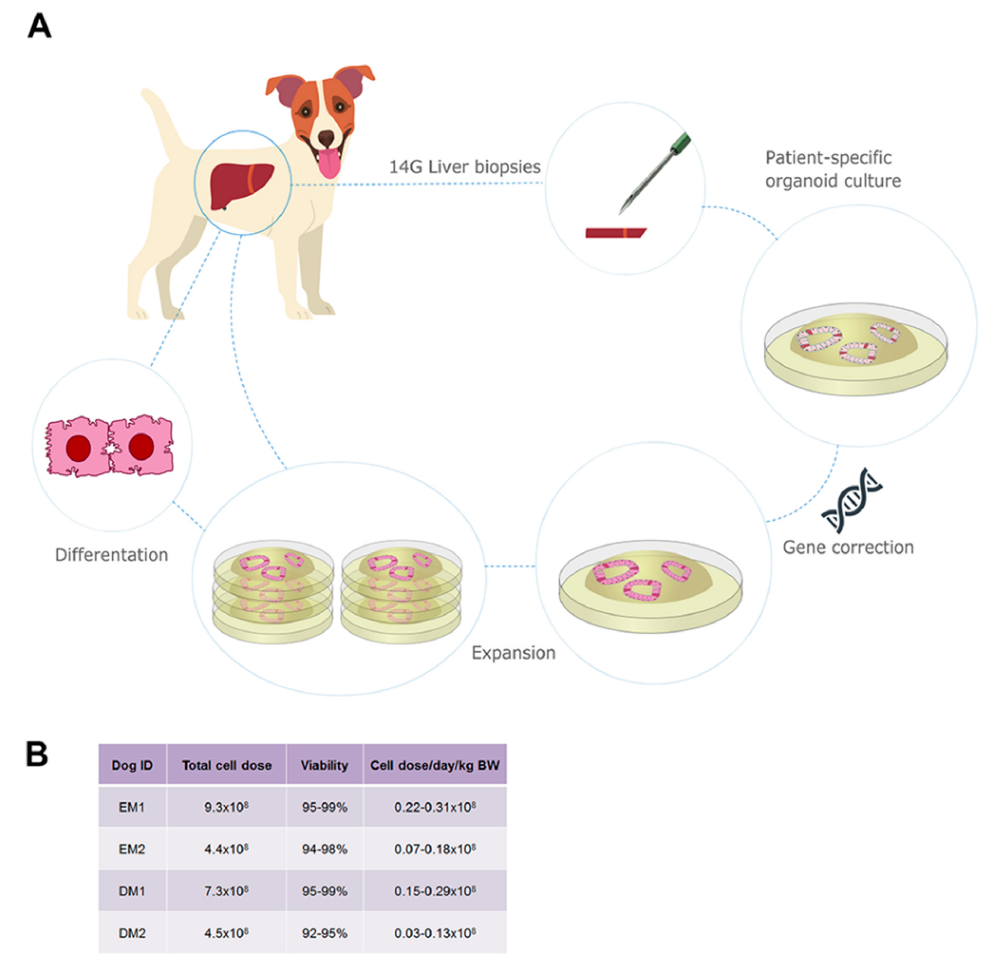
Figure 1. Establishment, genetic correction and expansion of autologous canine liver organoid culture